Question: How would you classify this visualization?
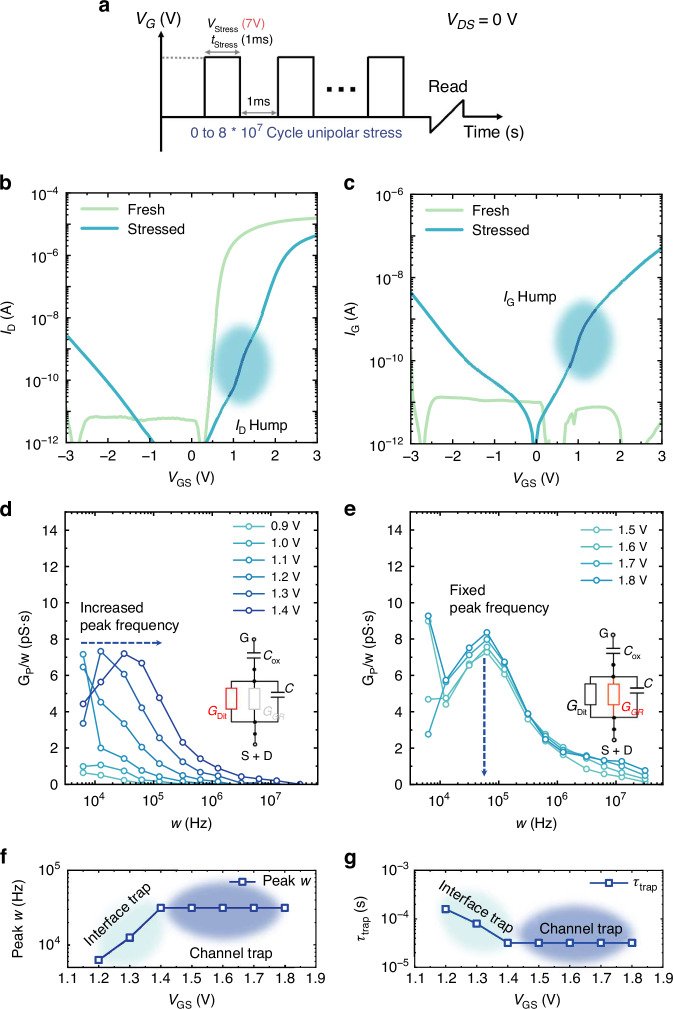
Answer: line